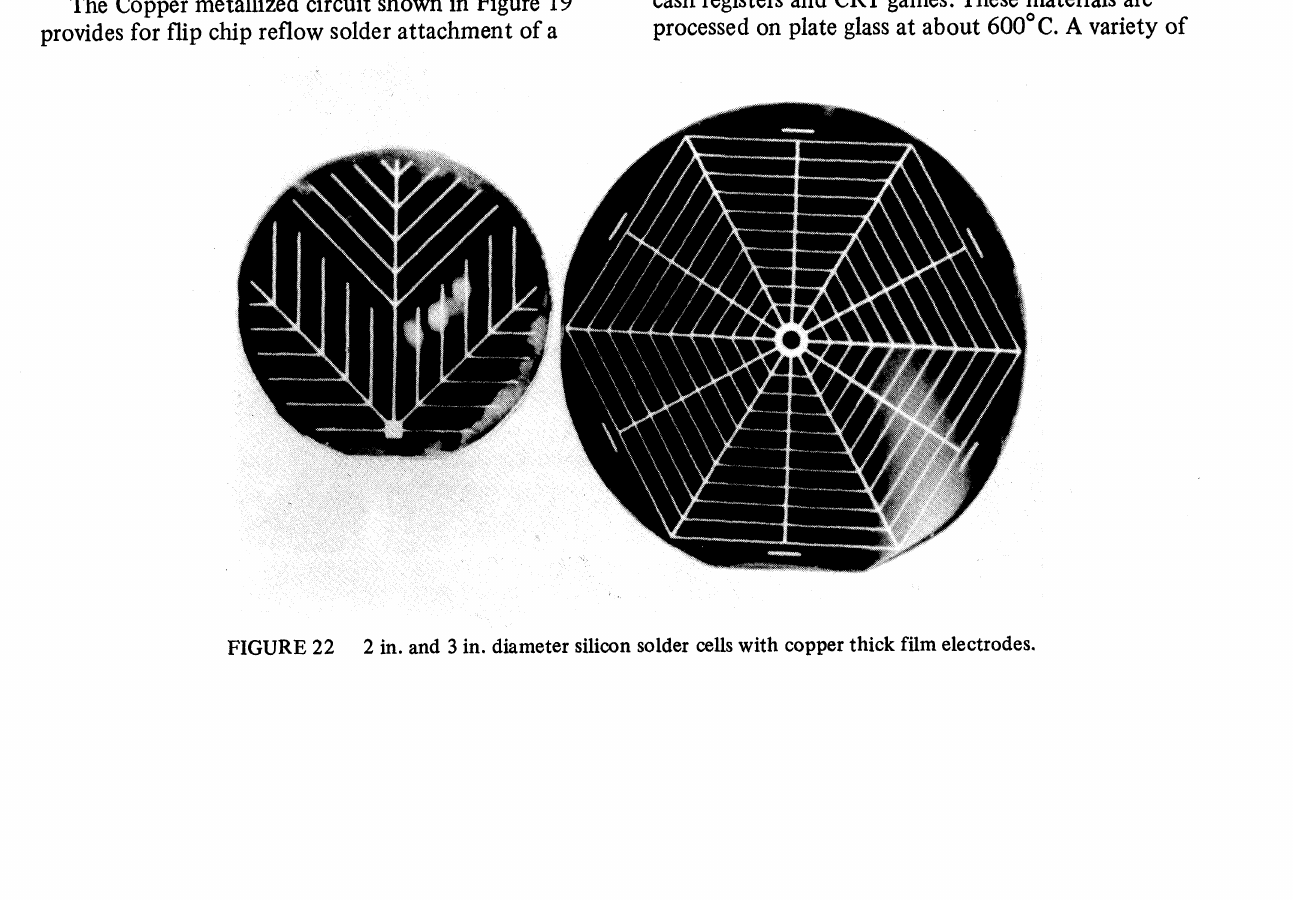
FIGURE 22 2 in. and 3 in. diameter silicon solder cells with copper thick film